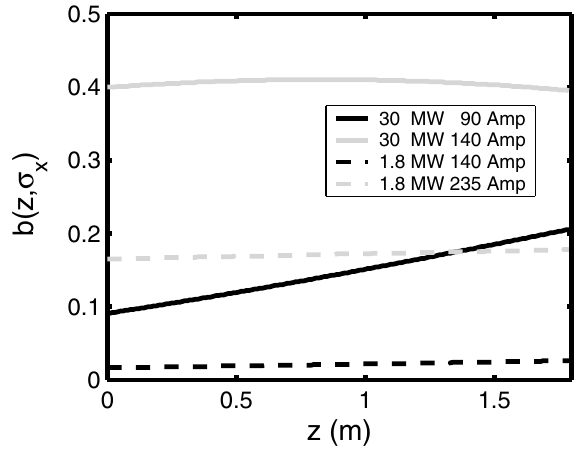
FIG. 6. Calculated bunching factors as a function of the radiator distance within the first two gain lengths using Eq. (4). The solid gray curve is for the maximum bunching where the seed laser power is 30 MWand the dispersion magnet current is 140 A ( d =d(cid:11) (cid:9) 8 : 7 ); the dashed black curve is for 1.8 MWseed laser power and 140 A dispersion magnet current; the solid black curve is for 30 MW seed laser power and 90 A dispersion magnet current ( d =d(cid:11) (cid:9) 3 : 5 ); the dashed gray curve is for 1.8 MW seed laser power and 235 A dispersion magnet current ( d =d(cid:11) (cid:9) 24 : 9 ). Gray curves represent the maximum bunching within the first gain lengths of the radia- tor, whereas black curves are calculated using parameters actually used during the experiment at each seed power case.